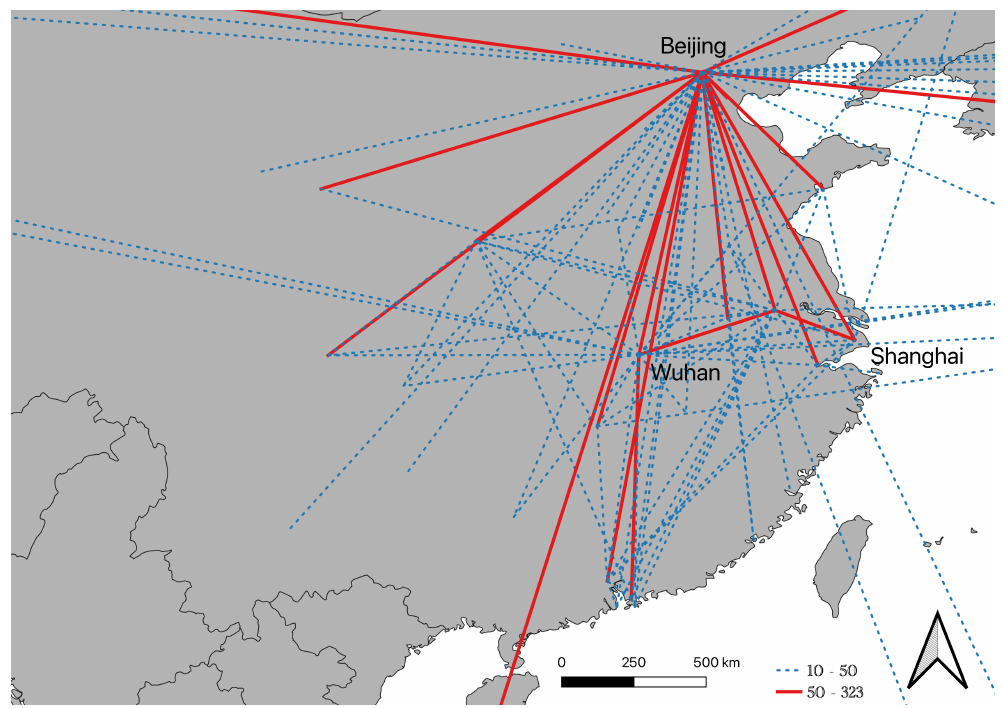
Figure 15. Connections of affiliations of articles published in Remote Sensing with an affiliation in China.